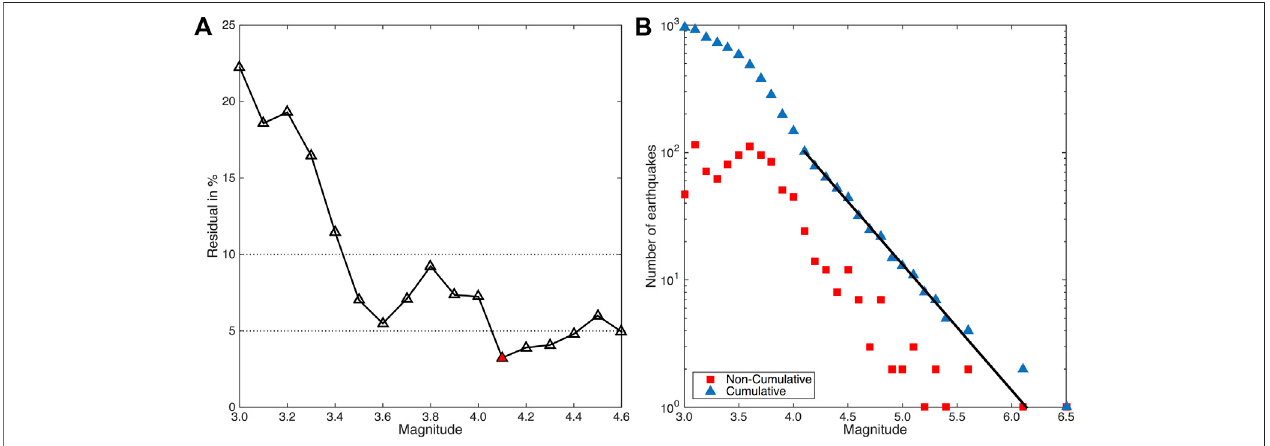
FIGURE3| Completenessmagnitude, M c ,estimationthroughtheGFTmethodfortheSouthernThessalyFaultSystemduringtheperiod1970 – 2020. (A) Residual in percentiles as function of the minimum magnitude bin of the observed catalog. Red triangle indicates the bin with residual below 5%. (B) Frequency-Magnitude Distribution (FMD) of incremental (red squares) and cumulative (blue triangles) number of the earthquakes. Straight black line represents the part of FMD above M c .